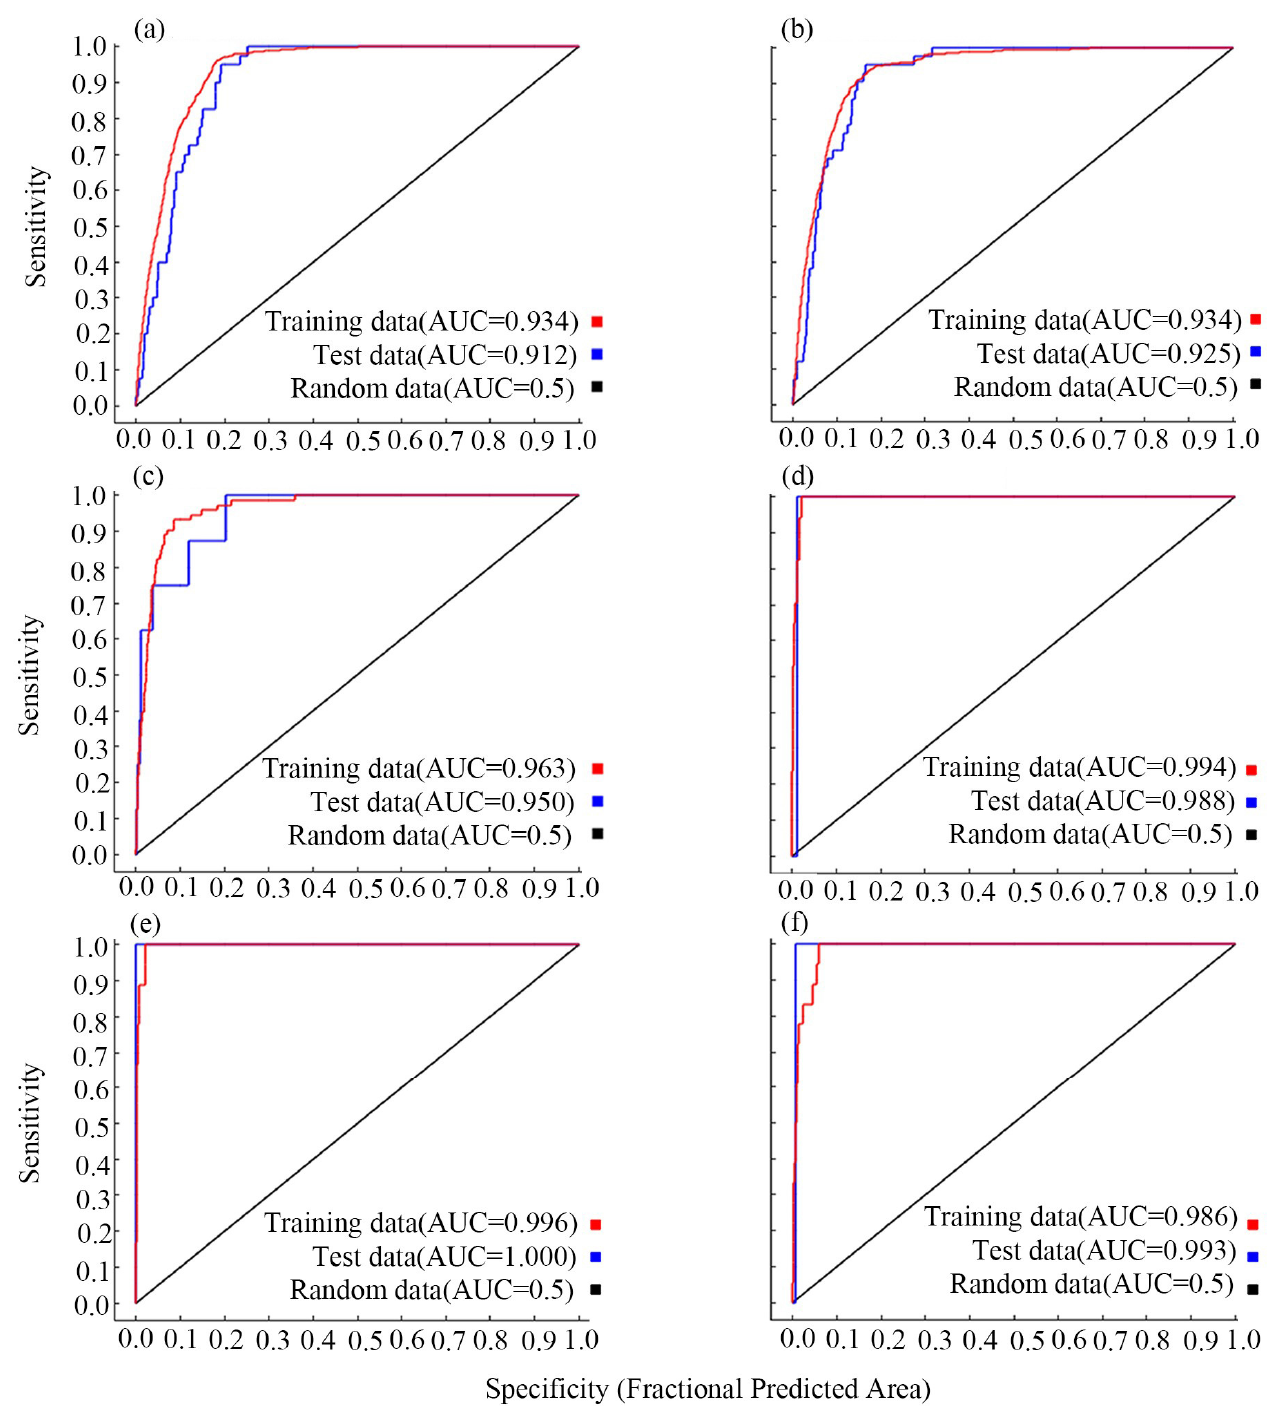
Figure 5. The receiver operating characteristic (ROC) curves of the mangrove species used to verify the MaxEnt model. ( a ) A. marina ( b ) A. corniculatum ( c ) K. obovata ( d ) B. gymnorrhiza ( e ) R. stylosa ( f ) A. ilicifolius .